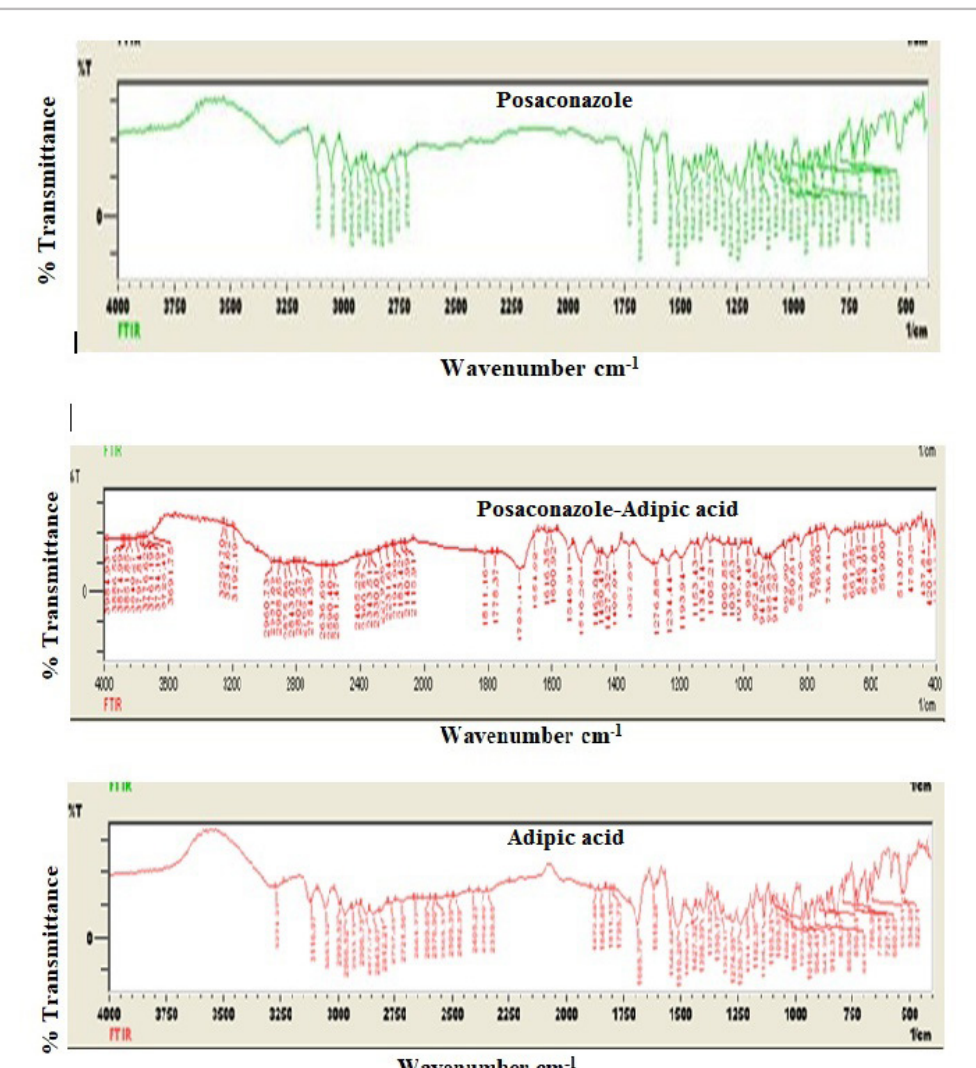
FIGURE 1 - FTIR spectral comparison of posaconazole, adipic acid and posaconazole-adipic acid co-crystals. TABLE I - F TIR bands for characteristic changes of posaconazole and posaconazole-adipic acid